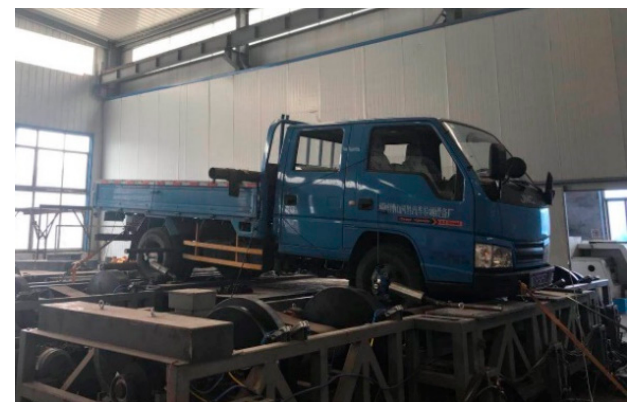
Figure 14. Vehicle test bench system.